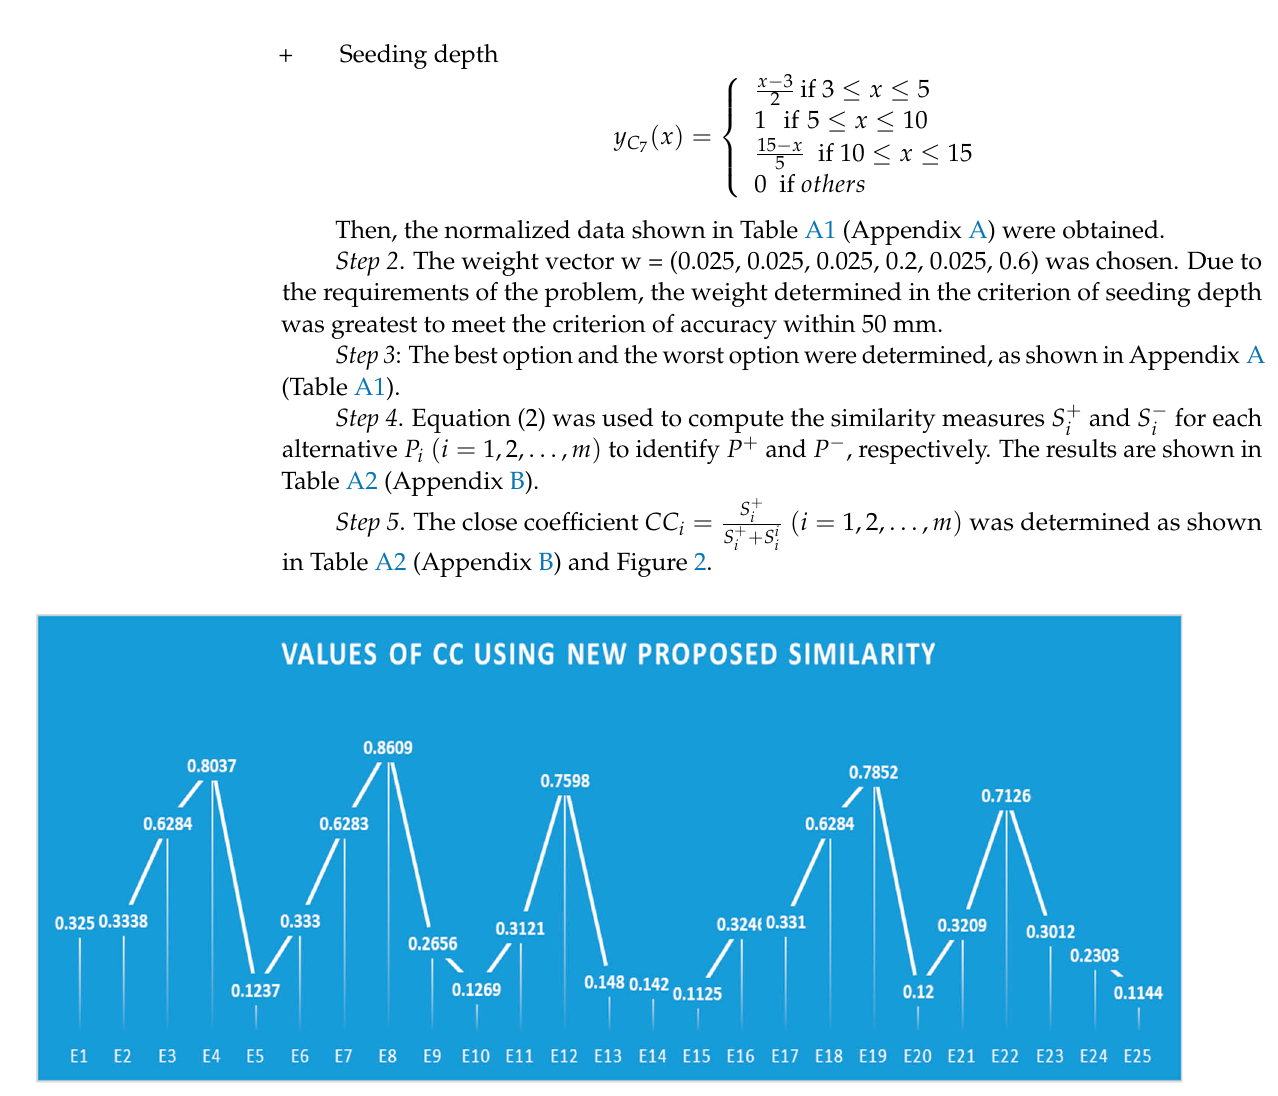
Figure 2. Values of CC using newly proposed similarity measure.